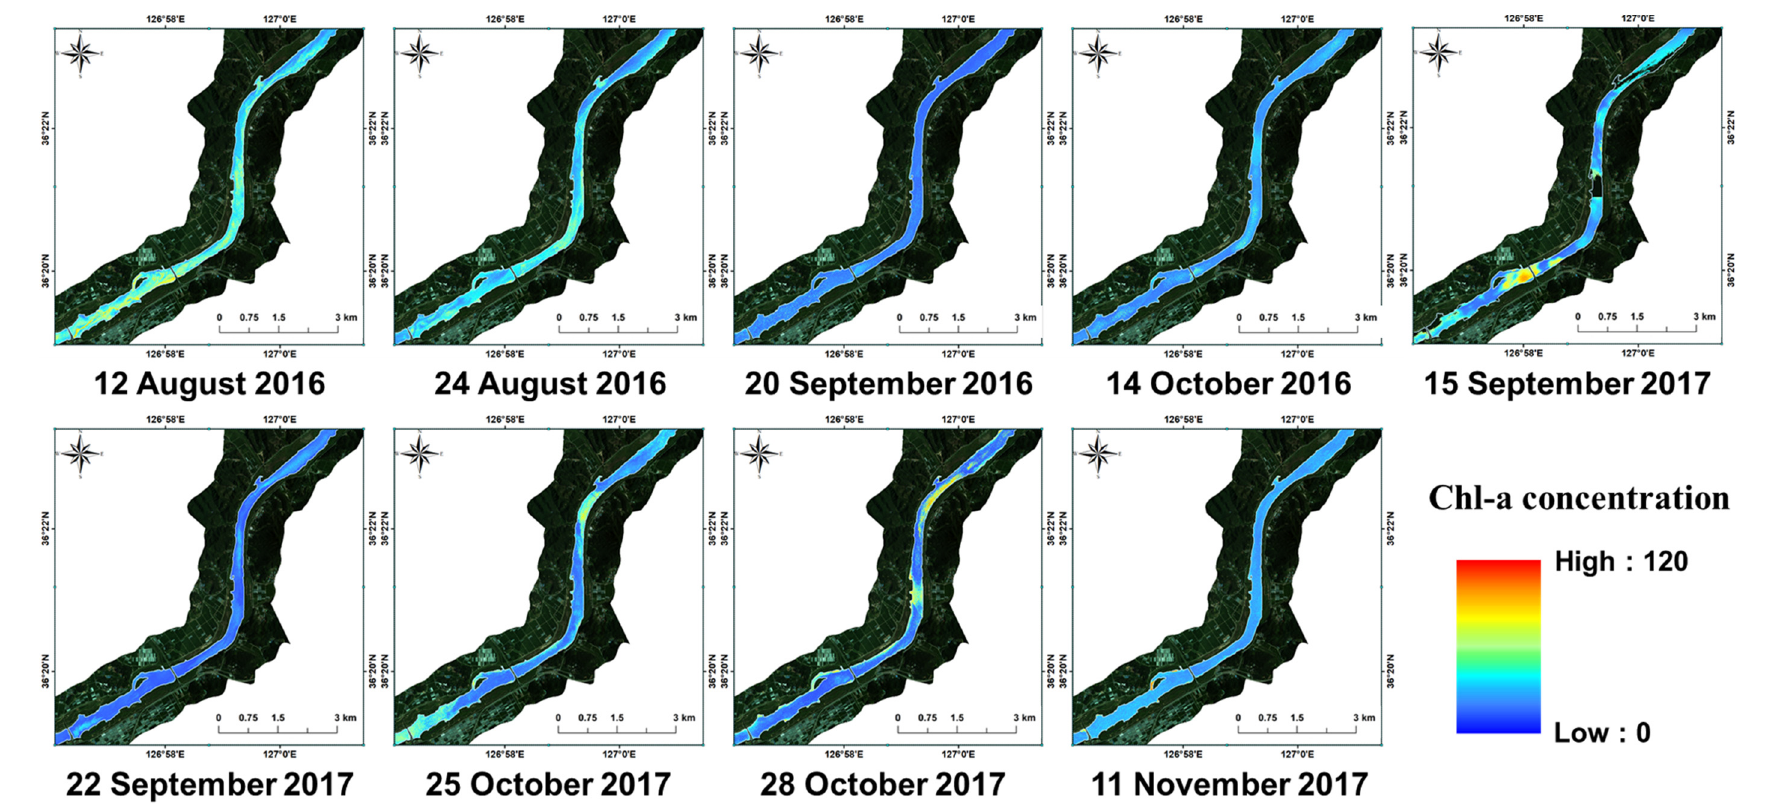
Figure 7. Spatio-temporal change estimation of chlorophyll-a concentration by applying artificial neural network to the hyperspectral imagery of the nine sampling dates.